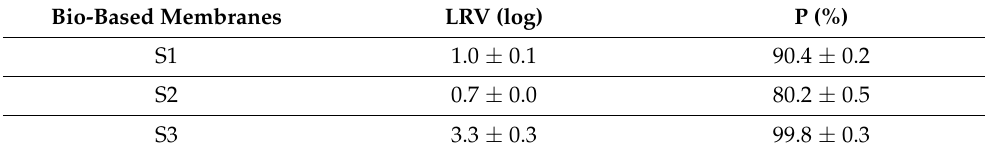
Table 3. Retention performances of E. coli bacteria by the bio-based membranes elaborated. Bio-Based